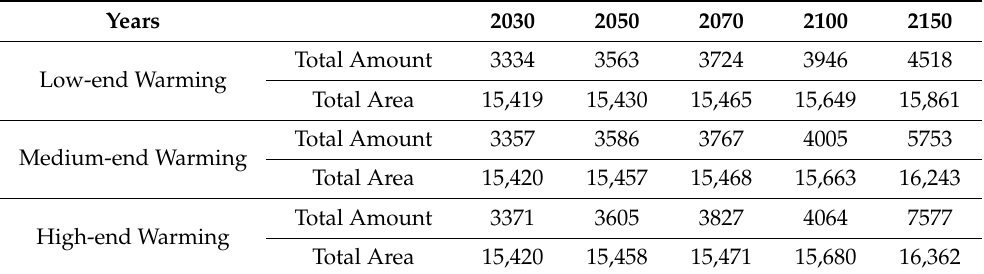
Table 2. Total amount of flooded properties and their total land area (million square feet) (years